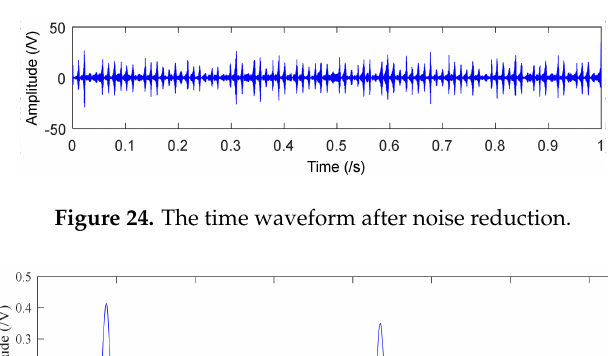
Figure 23. The time waveform of the original signal with an outer race defect.